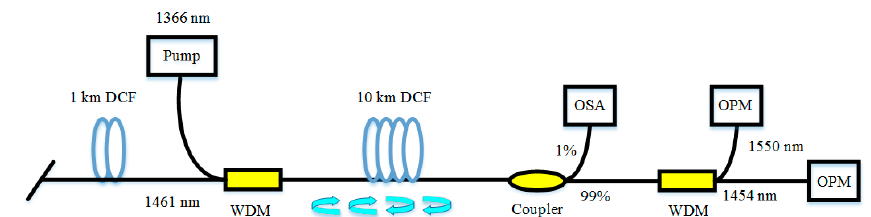
Figure 6. The schematic setup of the RFL is based on dispersion compensation fiber (DCF). OPM, optical power meter.